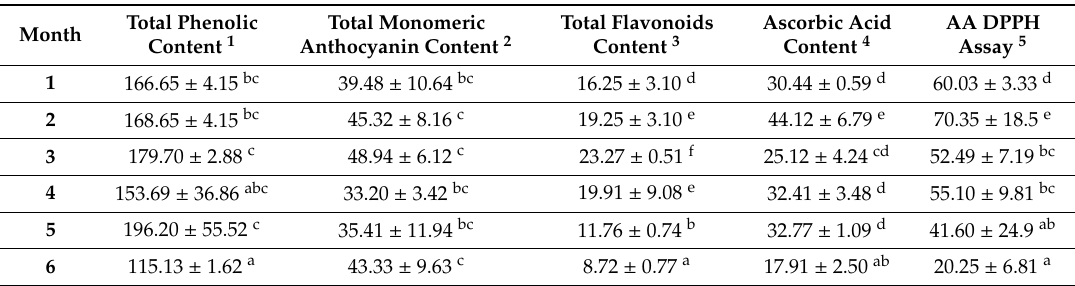
Table 6. Fruits stored at –20 ◦ C in freezer, packaged in Nanoactive A film. E ff ect of storage period on the total phenolic content, total monomeric anthocyanin content, total flavonoid content, the ascorbic acid content, and the antioxidant activity DPPH parameters in red raspberries (cv. Erika). The results are the mean of three replicates ± Standard Deviation. ** ( P ≤ 0.01); * ( P ≤ 0.05). The letters represent the significant di ff erence vertically at P ≤